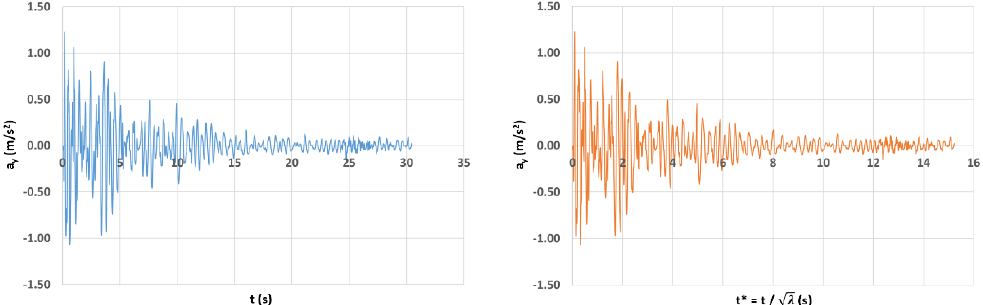
Figure 2. Seismic acceleration vs. time: real earthquake accelerogram ( left ); scaled accelerogram ( right ).